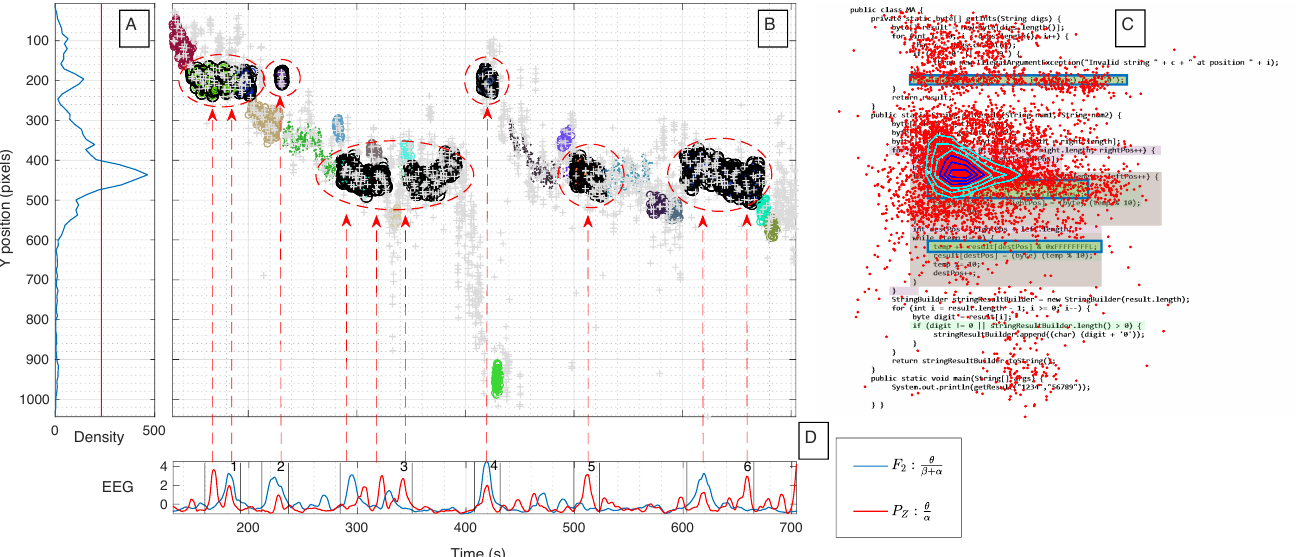
Figure 11. Example of the fusion of EEG with eye tracking, for an expert participant during the Code task 2. ( A ) Density of gaze points, with the red line as a reference of 50% of the maximum row density; ( B ) clusters of gaze points over time and the y-axis; ( C ) code task figure overlapped with gaze points; and ( D ) discriminant EEG features values over